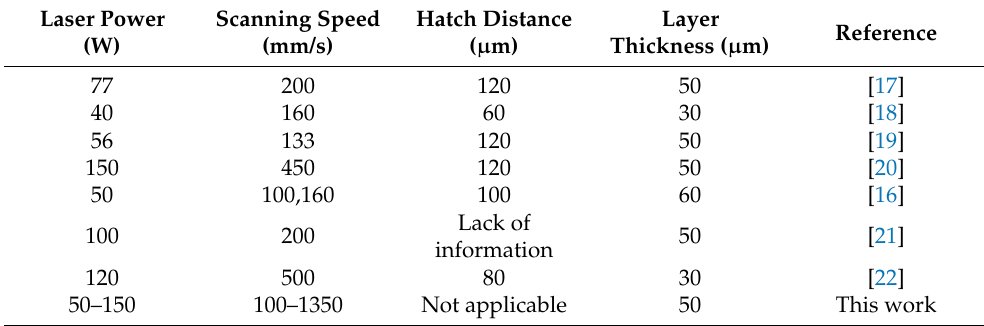
Table 1. The parameter combinations for the printing of NiTi are reported in the literature.